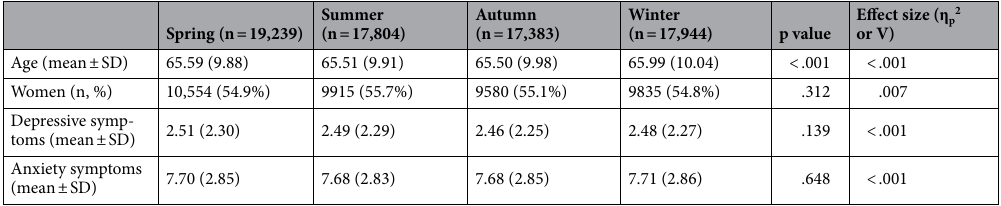
Table 1. Characteristics of participants by season of